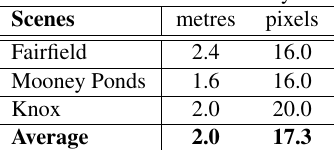
Figure 7: Building detection by the previous (left) and the improved (right) algorithms on two samples from Knox. Table 3: Geometric